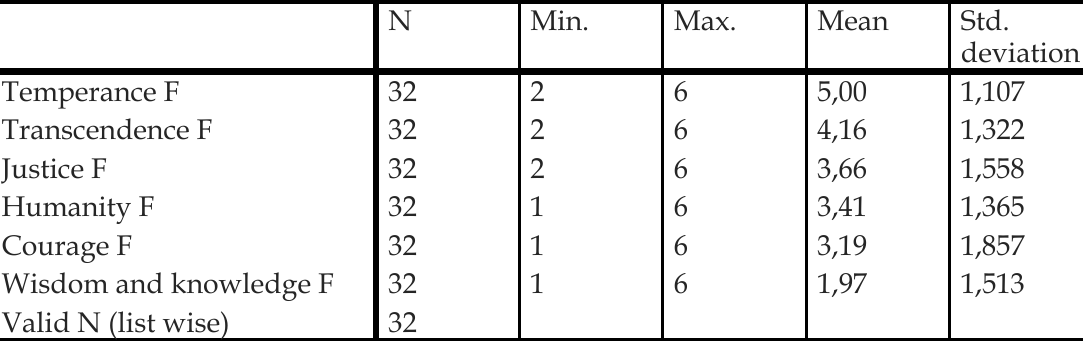
Table 2. Importance of signature strengths in the perception of foreign students. Source: Own